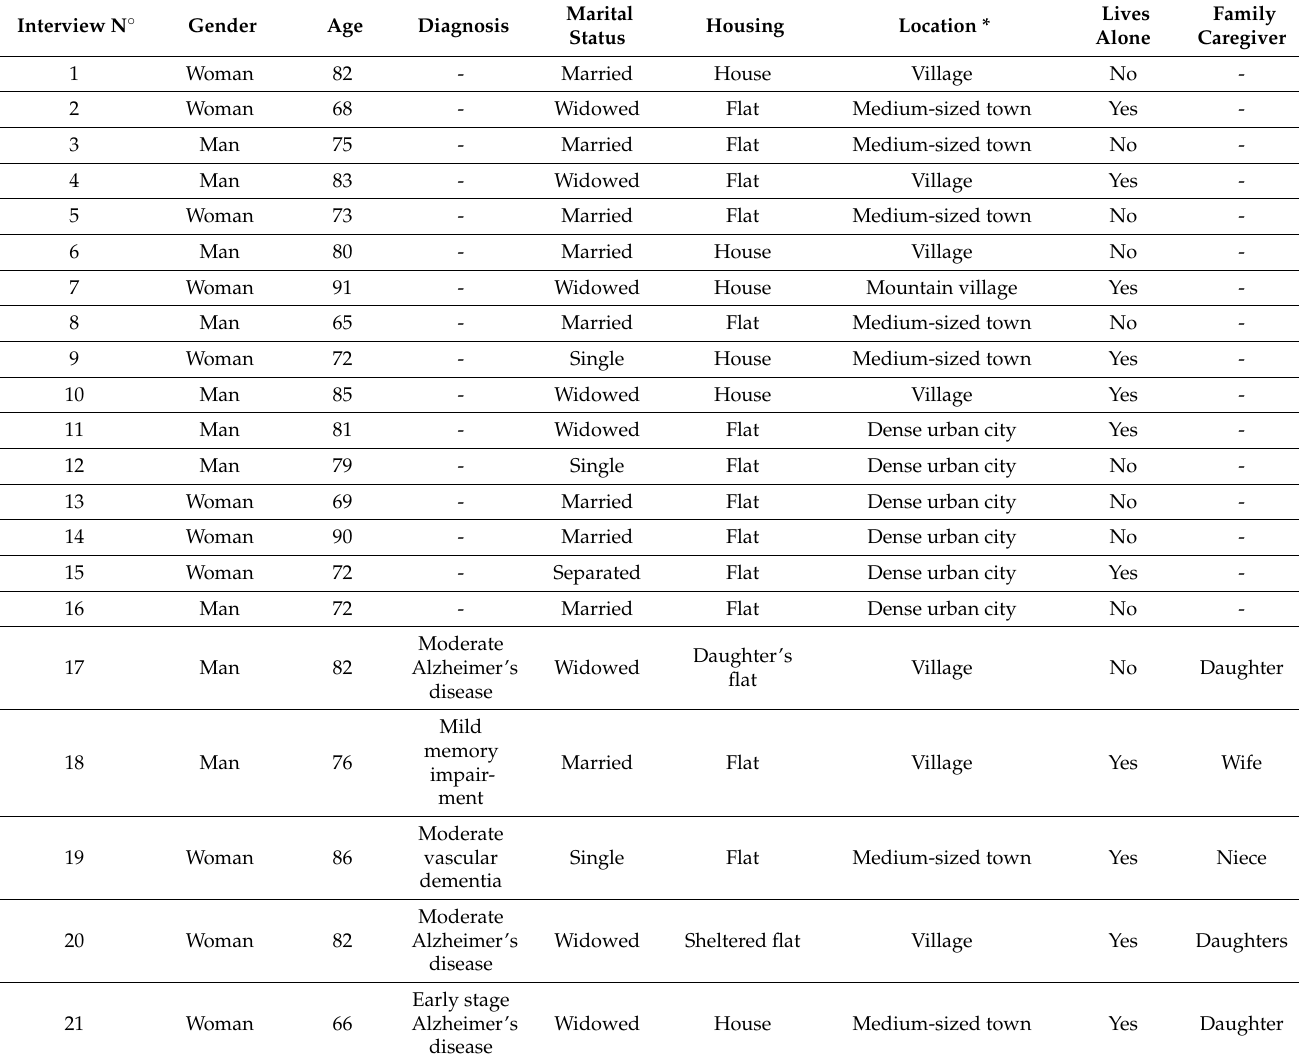
Table 1. Participants’